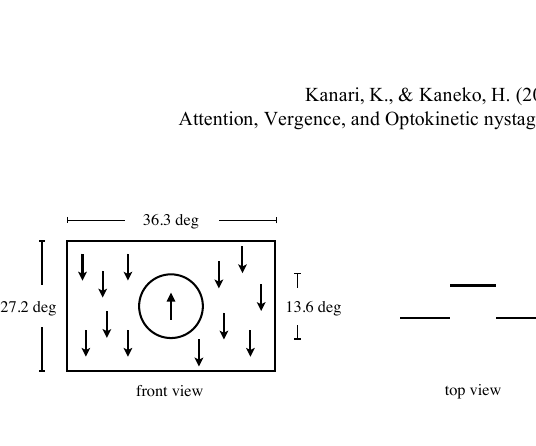
Figure 2. Schematic illustration of stimulus: Left and right panels, respectively, show front and top view of stimuli. Arrows show direction of motion. Circle (not actually presented) show border of area where dots were presented. Central and peripheral areas have different